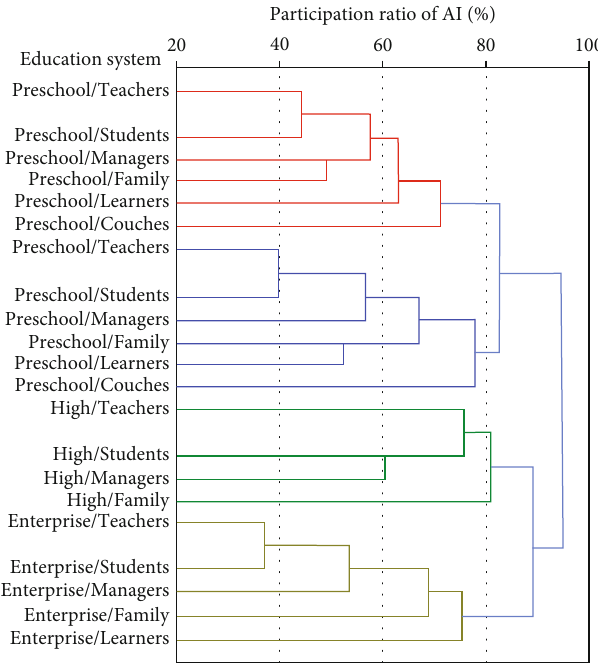
Figure 4: Analysis of mechanism by which AI a ff ects role cognition in the education system. Table 4: Rating results of e ff ects of AI on di ff erent role recognition descriptions in the education system in Taiyuan City (note: PSE: preschool education; PE: primary education; SE: